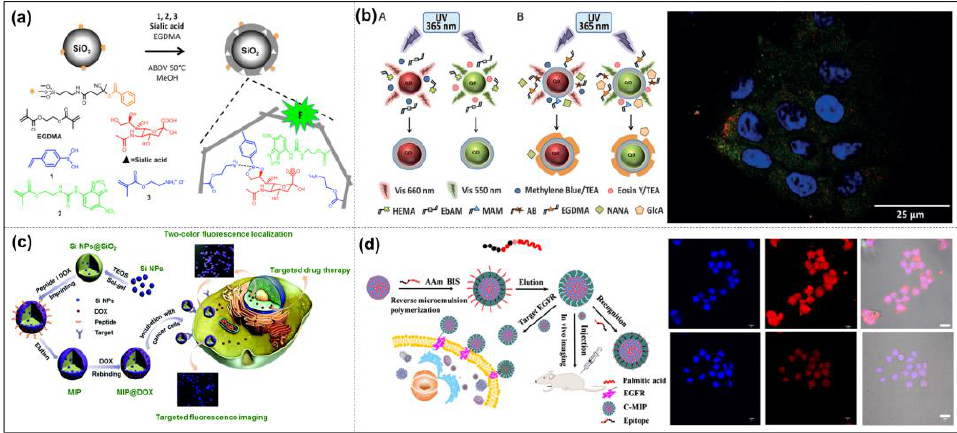
Figure 10. Procedure for SA-imprinted shell on silica core particles by a mixed covalent and non-covalent approach ( a ); red or green light emitted from InP/ZnS quantum dots excited by irradiation is used to synthesize a polymeric shell in situ around the particles by photopolymerization and the second shell of MIP is synthesized. Confocal microscope image showing simultaneous multiplexed staining of GlcA and NANA by MIPGlcA-QDs (green) and MIPNANA-QDs (red) ( b ); illustration for preparation of MIPs for targeted fluorescence imaging and targeted therapy in the cancer cell ( c ); preparation and application diagram of directed fluorescent MIP-NPs for cervical cancer tar- geted imaging and confocal fluorescence imaging of HeLa cells incubated with MIP-NPs and NIP-NPs 4h, respectively ( d ). Reprinted with permission from Ref. [83,138,140,153]. Copyright 2015, ACS; 2016, Wiley; 2019, Royal soc of chemistry; 2020, Springer.